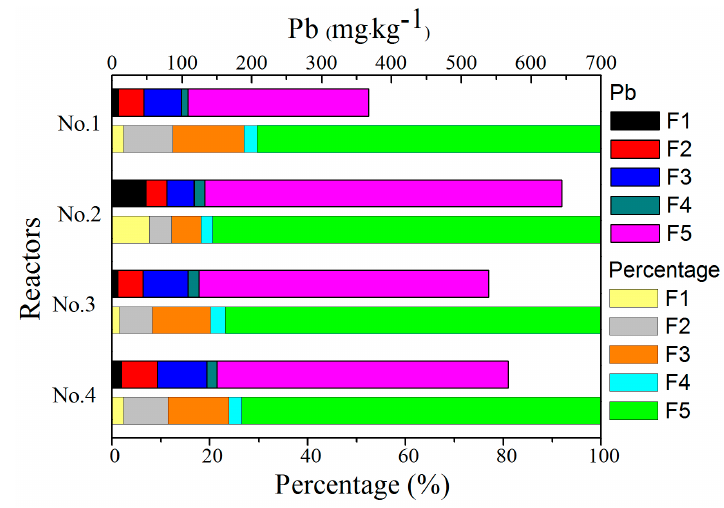
Figure 11. Lead adsorptions (mg · kg − 1 ) and percentages in different fractions (exchangeable [F1], bound to carbonate [F2], bound to iron and manganese oxides [F3], bound to organic matter [F4], and residual [F5]) at the four bioretention reactors.